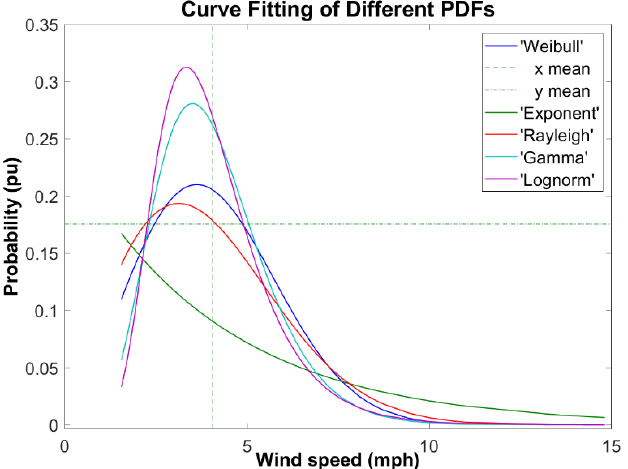
Figure 5. Wind speed curve fitting of five different distributions that are considered in this work for machine learning analysis [36].